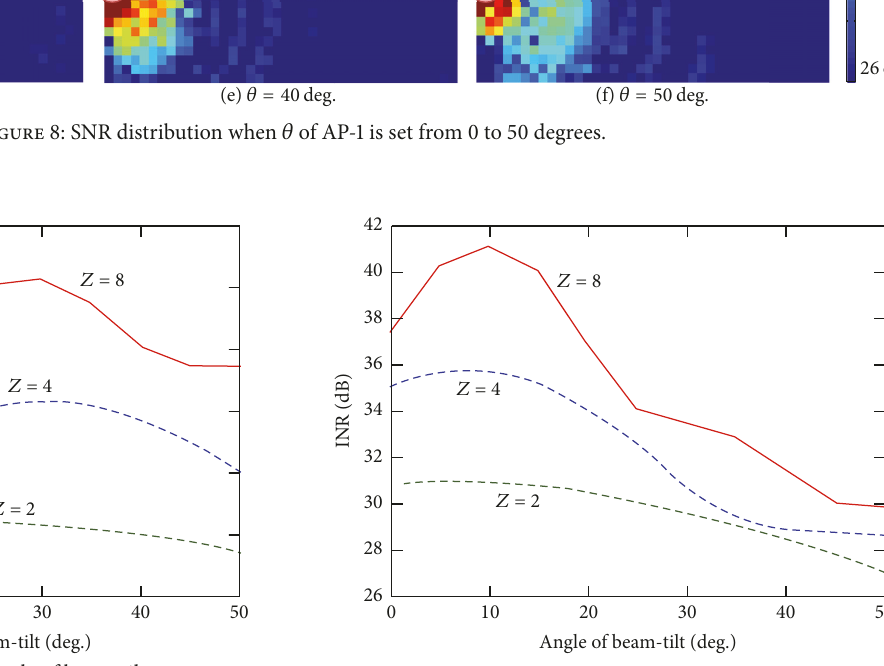
Figure 10: INR versus angle of beam-tilt.